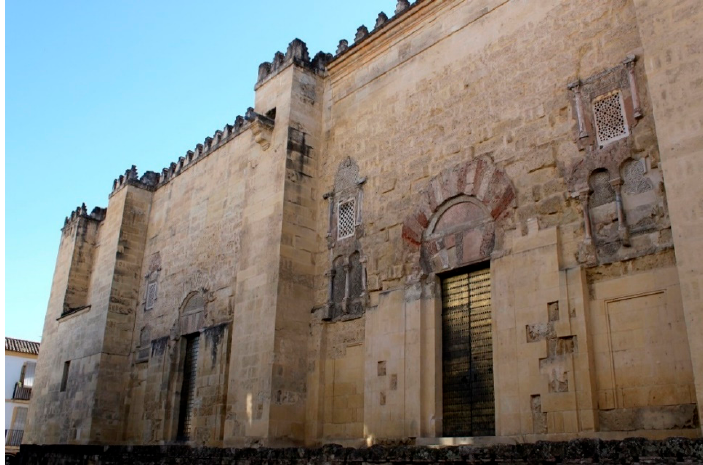
Figure 13. Great Mosque of Cordoba. Southeastern doors of the Hisham II’s enlargement. © Photo took by